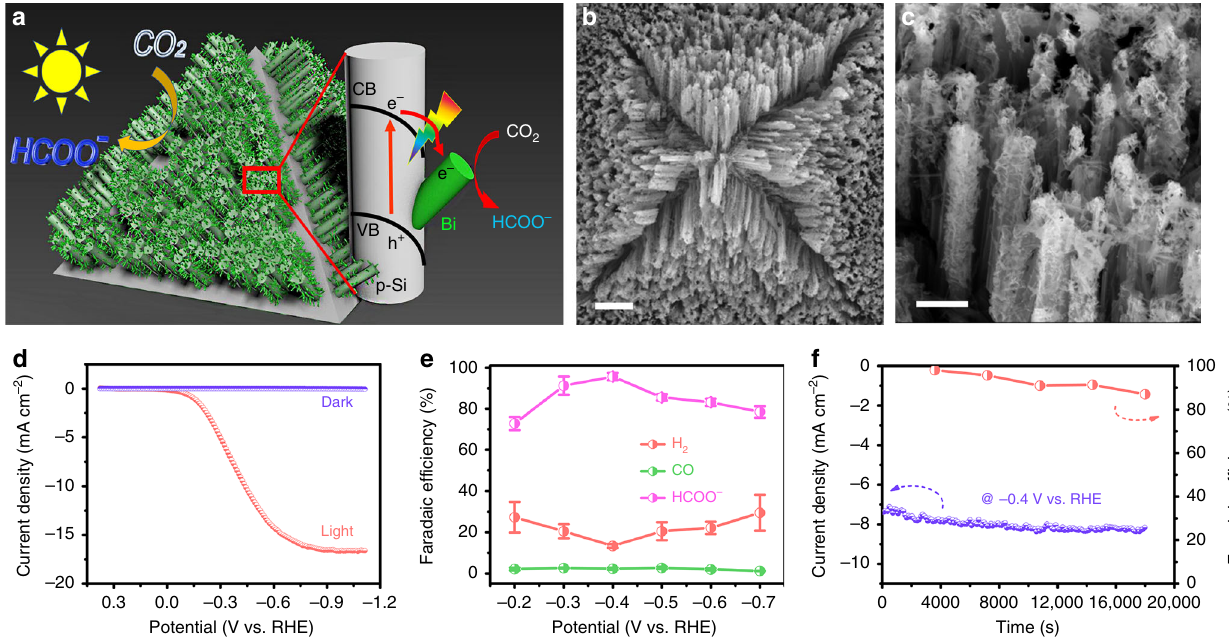
Fig. 5 Photoelectrochemical carbon dioxide reduction on Si/Bi photocathode. a Schematic illustration of the structure of the Si/Bi photocathode and its working mechanism for PEC CO 2 RR. b , c SEM images of Bi 2 O 3 nanotube (NT)-loaded Si nanowire array photocathode. d Polarization curves of Si/Bi under dark or 0.5 sun illumination. e Potential-dependent Faradic ef fi ciencies for HCOO − , CO, and H 2 from PEC. f Change of total current density and formate Faradaic ef fi ciency at ‒ 0.4 V with time. Scale bar, 5 μ m ( b ); 1 μ m ( c